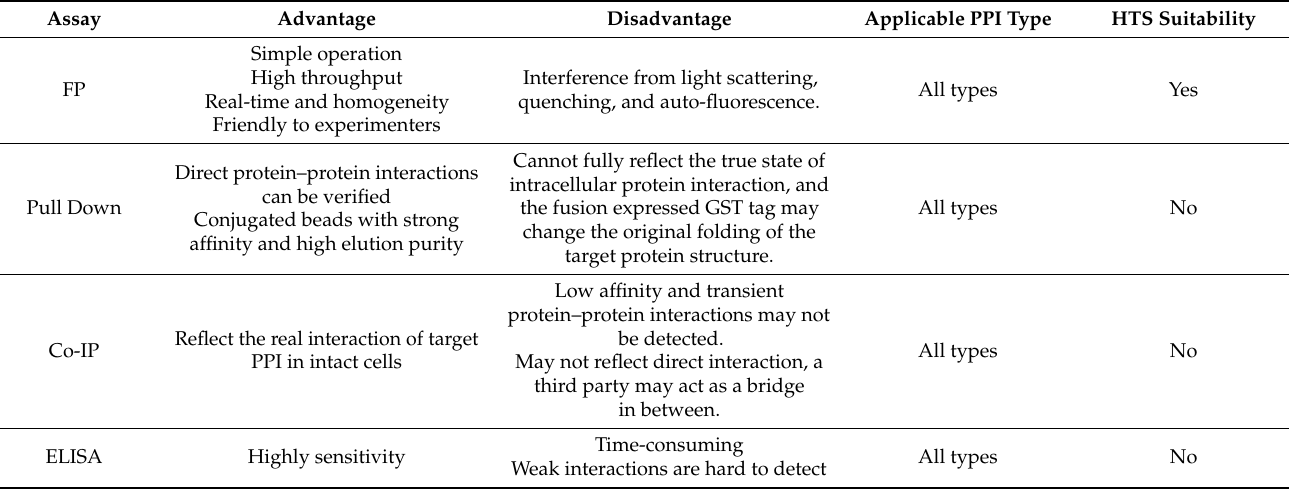
Table 3. Comparison of competitive-based analysis